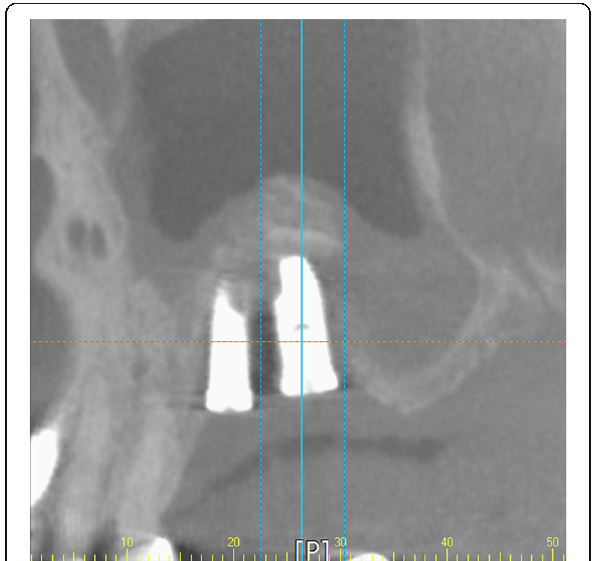
Fig. 4 Postoperative CBCT view 4 months